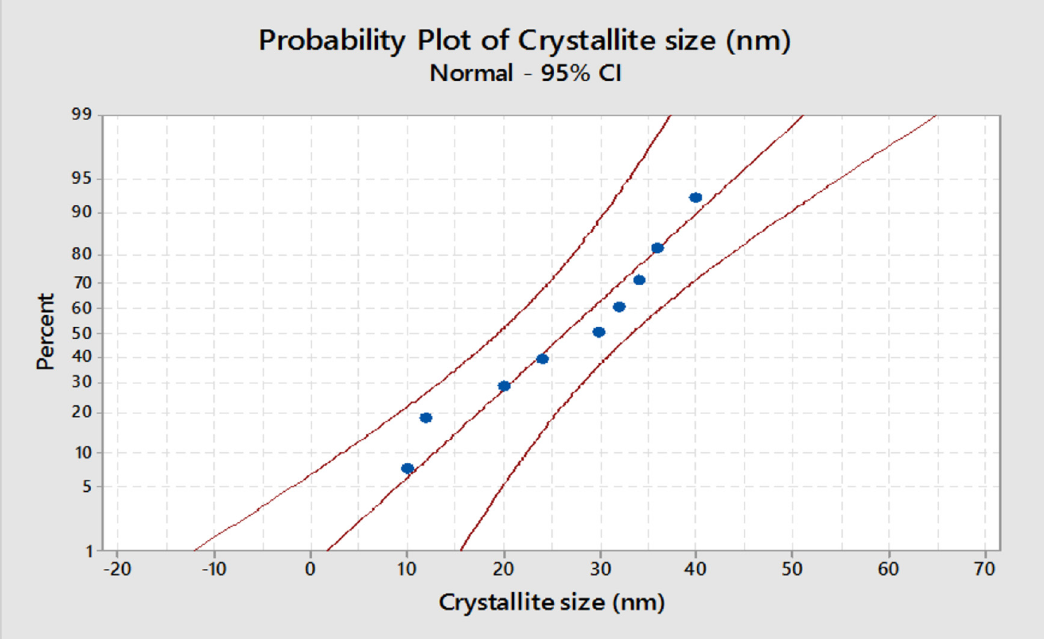
Fig. 7. Probability plot of crystallite size.